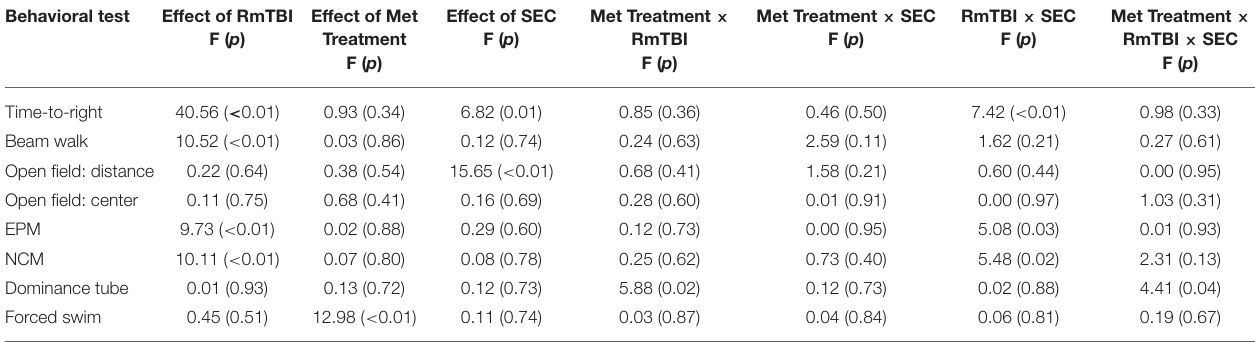
TABLE 1 | Statisitcal results of the three-way anovas for the behavioral assessment of rmtbi, aas treatment, and SEC in adolescent rats. Behavioral